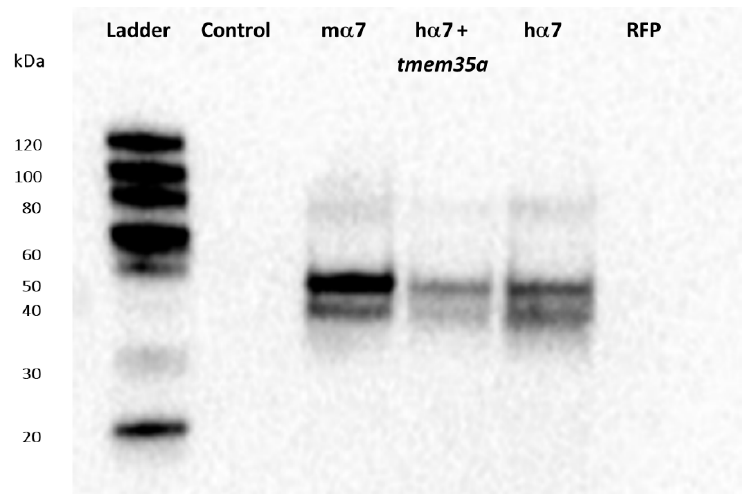
Figure 2. Western blot assessment of Synaptic Systems antibody against mouse α 7nAChR. Antibody #8360 showed high specificity against human and mouse α 7nAChRs and likely rat α 7 given the identical C-terminal (antigen) sequence. Mouse α 7 (100% mchrna7 ), human α 7 (100% hchrna7 ), and human α 7 + NACHO (50% hchrna7 + 50% htmem35a DNA) transfected HEK cells showed bands corresponding approximately to the expected molecular weight (MW, ~55 KDa) and higher MW bands are also visible. Untransfected HEK-293 cells and cells transfected with Red Fluorescent Protein (RFP, a transfection control) showed no bands. Figure S2 shows that these constructs allowed surface 125 I- α BGT binding when transfected into HEK cells, but not C-terminal FLAG tagged mchrna7 . These in vivo results contrast sharply with previous in vitro results. Gu et al. [3,4] report that RIC3 and NACHO act synergistically in HEK cells to promote surface α 7nAChR expression as measured by electrophysiological recording and fluorescent α BGT binding. However, they did not demonstrate the e ff ect of varying ric3 and tmem35a cDNA ratios on surface α 7nAChR expression. Alexander et al. [23] demonstrated that di ff erent ratios between ric3 alone and chrna7 su ffi ciently induce di ff erential surface α 7nAChR expression, with high ric3 to chrna7 ratios causing internal receptor aggregation and retention, resulting in an inverted U-shaped expression curve. Similarly, Ben-David et al. [24] noted an inverted U-shaped expression curve with varying amounts of mouse ric3 cRNA injected with a fixed amount of chrna7 cRNA into oocytes. These data suggest that the ratios between the three genes ( ric3 , tmem35a , and chrna7 ) will be important factors determining total surface receptor expression. We investigated the e ff ects of maintaining chrna7 level equal to the sum of the two chaperones in HEK cells (Figure 6). RIC3 promoted surface α 7nAChR expression in HEK cells as evident by α BGT binding even with the absence of NACHO expression (Figure 6). The e ff ects were synergistic as a 3:1 tmem35a to ric3 ratio produced a threefold greater response than either gene